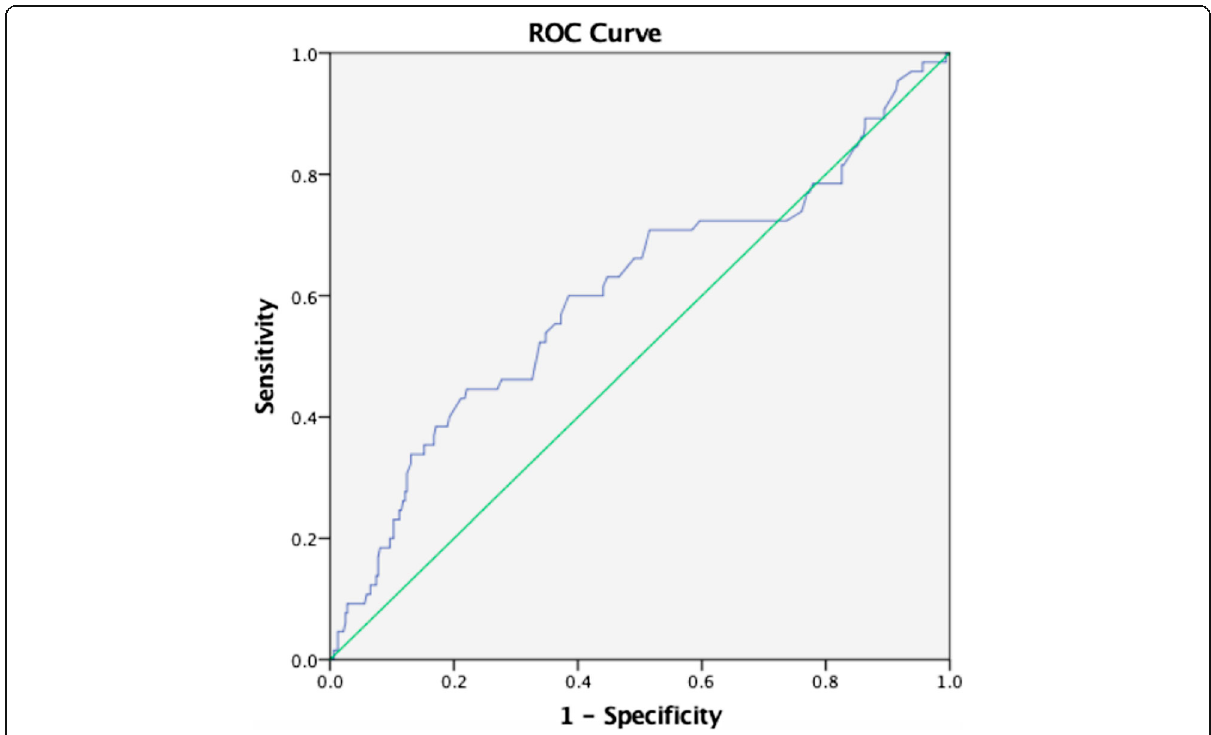
Fig. 6 Graphic representation of ROC curves for overall